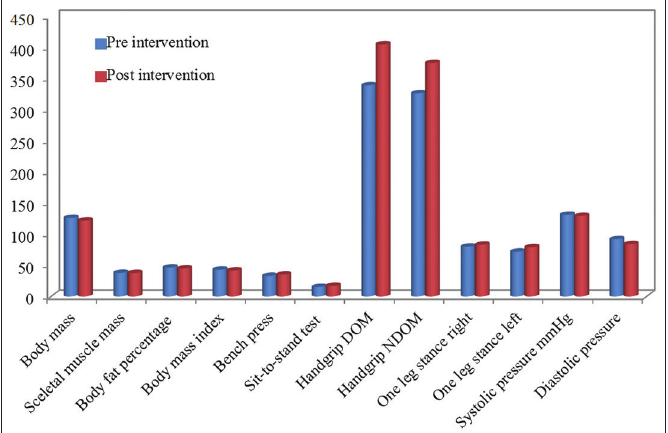
FIGURE 2. Physical ability parameters before and after programmed physical activity (PA) intervention (10‑week training PA program).